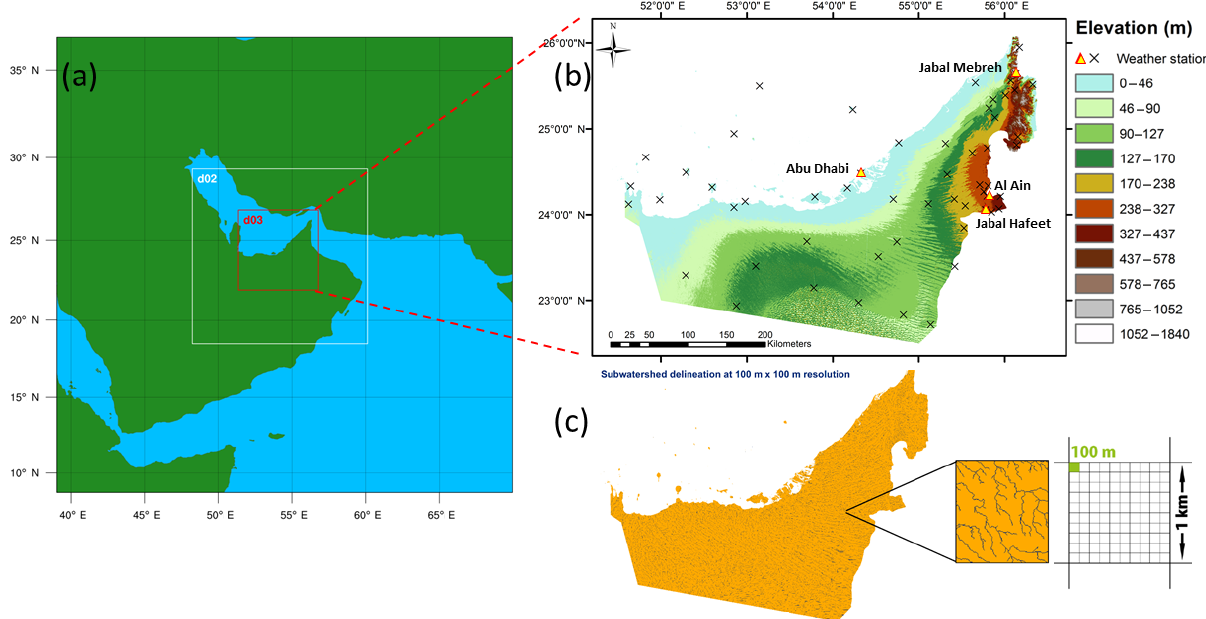
Figure 1. WRF model nested domains at 9, 3 (d02), and 1km (d03) horizontal resolutions (a) , 30m ASTER DEM with station locations (b) , and the 100m WRF-Hydro grid derived over the UAE (a)